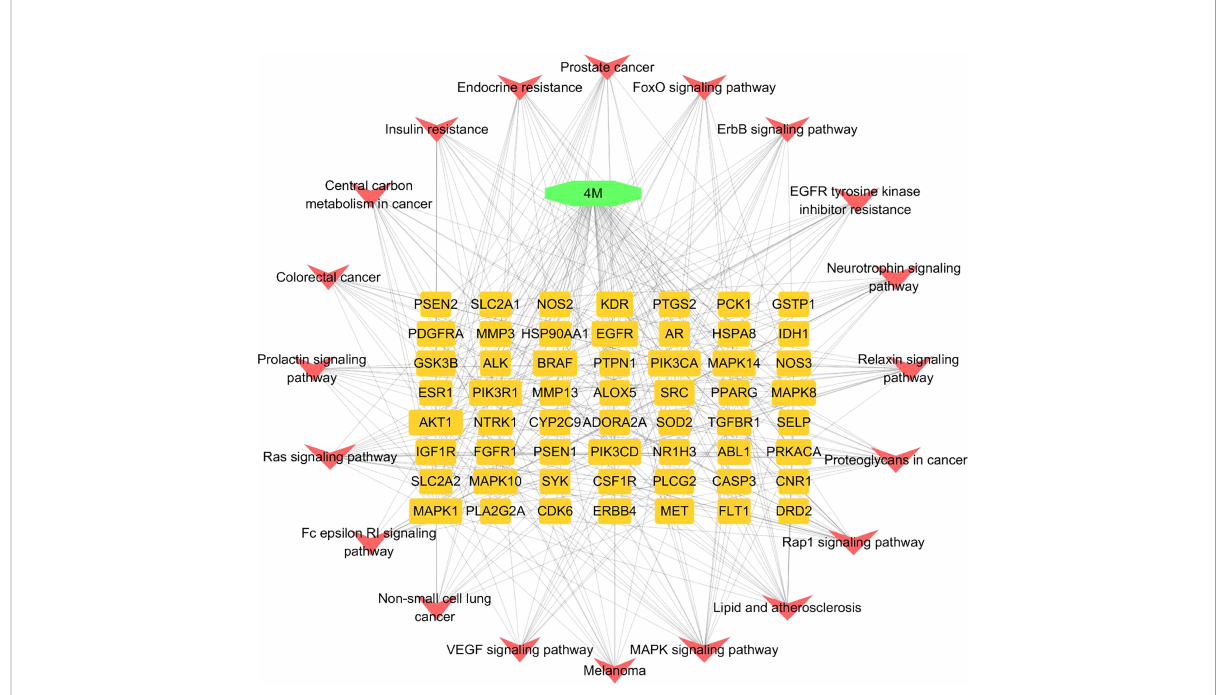
FIGURE 7 Constituent – target – pathway network of top 20 pathways. (The nodes in green stands for compound 4m. Each yellow oblong on the inner circle stands targets. Each red V node stands for each pathway.).